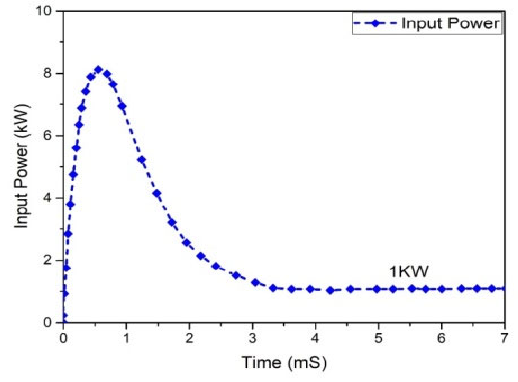
Figure 15. Boost converter input power.